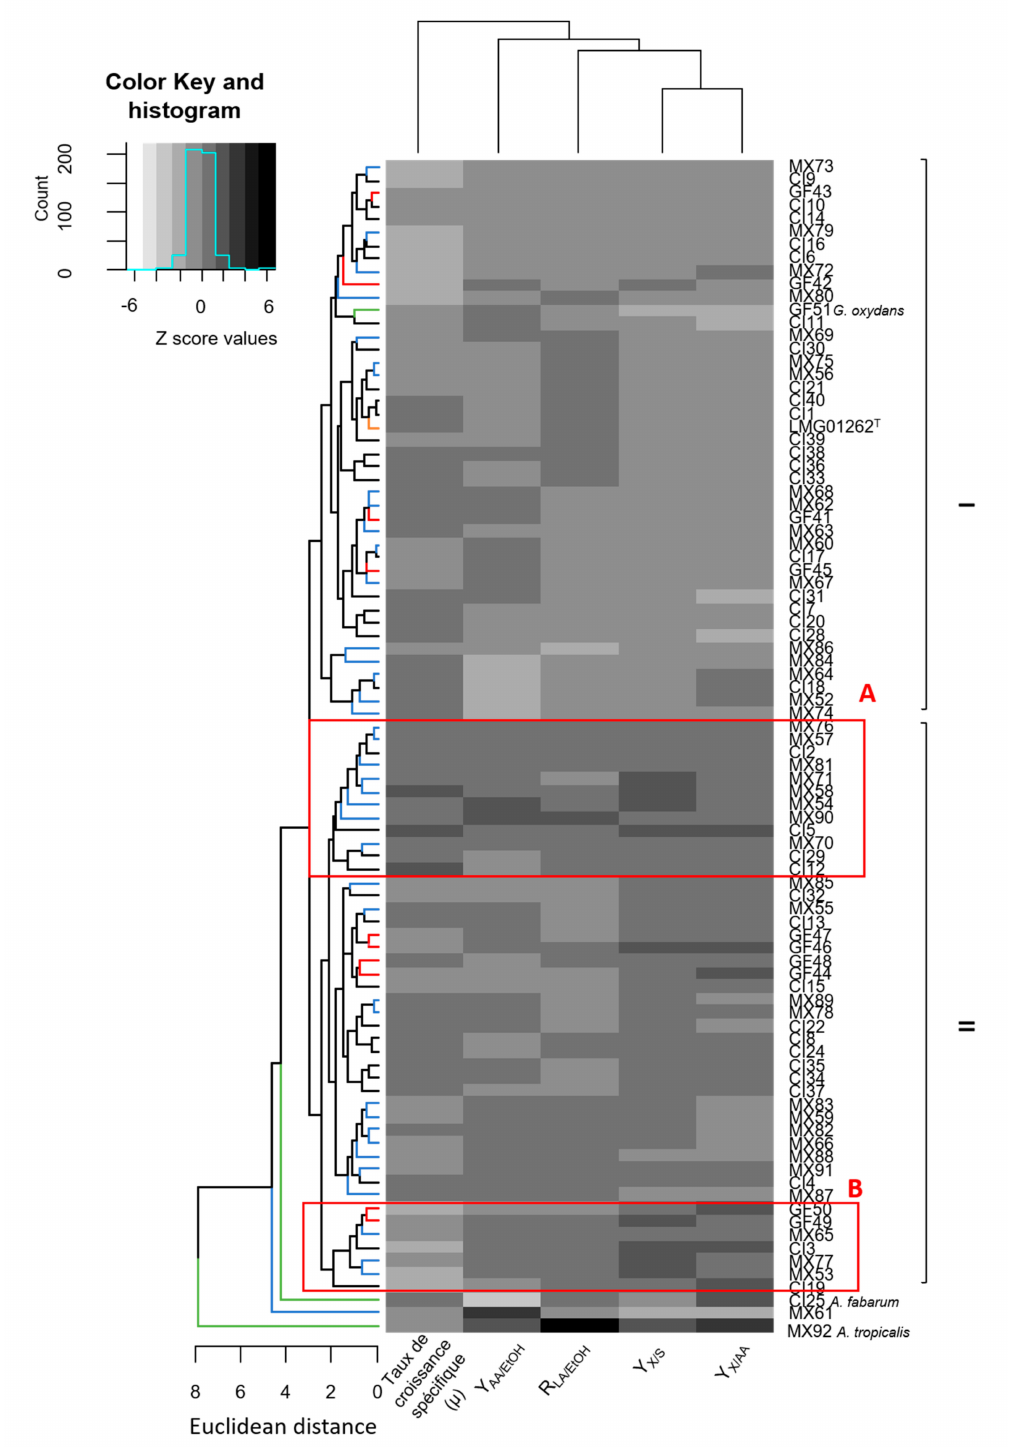
Figure 1. Biochemical relatedness of the 86 Acetobacter pasteurianus strains, the A. pasteurianus -type strain, and the 3 AAB. The measurements were converted into Z-scores, pairwise similarities were calculated by Euclidean distance, and an UGPMA clustering algorithm was applied in order to cluster the data. With the Y EtOH/AA = conversion efficiency of ethanol into acetic acid, R LA/EtOH = correspond to the lactic acid consumption divided by the ethanol consumption, Y X/S = biomass yield, Y X/AA = biomass yield produced by acetic acid produced, and specific growth rate ( µ ). X was the biomass, S = substrates consumption, LA = lactic acid, AA = acetic acid, and EtOH = ethanol. The tree branches were colored according to the strain origin: Mexico (blue), Ivory Coast (black), French Guiana (red), type strain (brown), and the three other AAB species in green. The red squares are the two subsclusters containing interesting